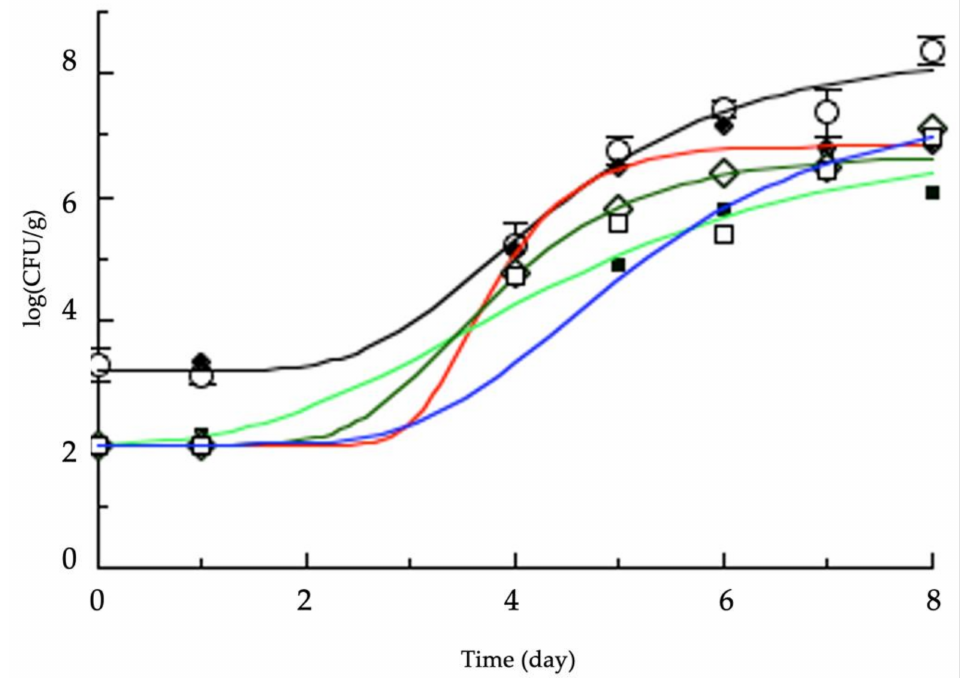
Figure 1. Best fit of modified Gompertz equation (Equation (1)) to the experimental data on the growth kinetics of Pseudomonas spp. Experimental data are presented as means ± standard